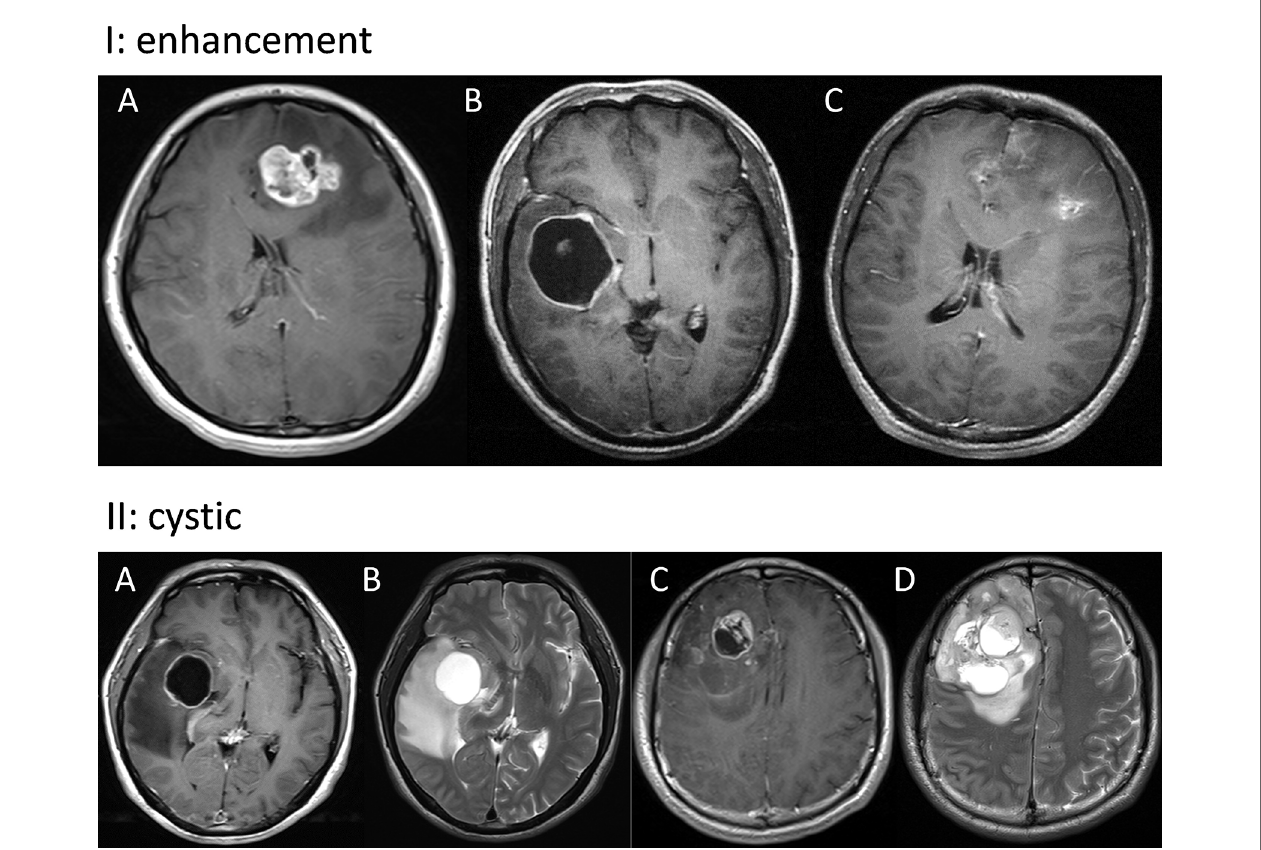
FIGURE 1 | Panel I: Representative images of solid (A) , ring (B) , and irregular (C) enhancement. Panel II: Typical images of cystic GBM. A tumor in the right insular lobe with fl uid- fi lled cysts (A, B) and a tumor in the right frontal lobe with large central necrosis (C, D)